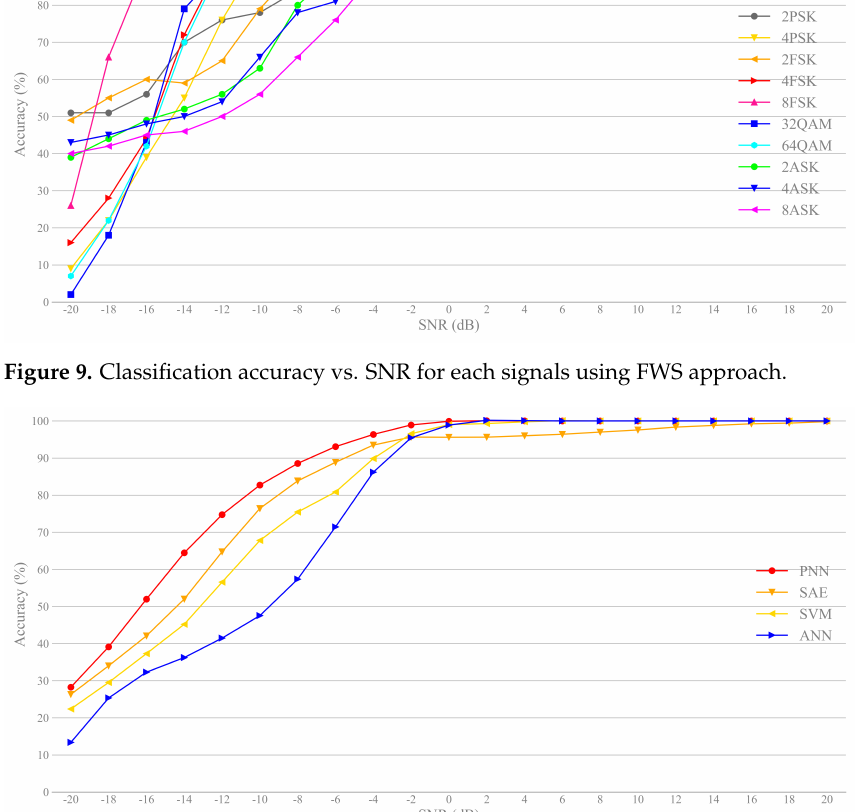
Figure 10. Comparison of different classifiers using FWS